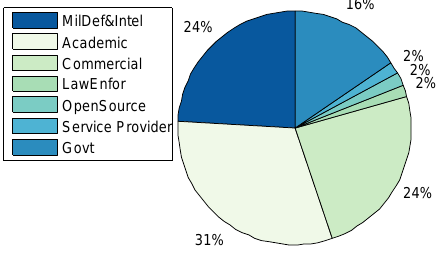
Figure 4. Cyber-Range Domain of Applications.